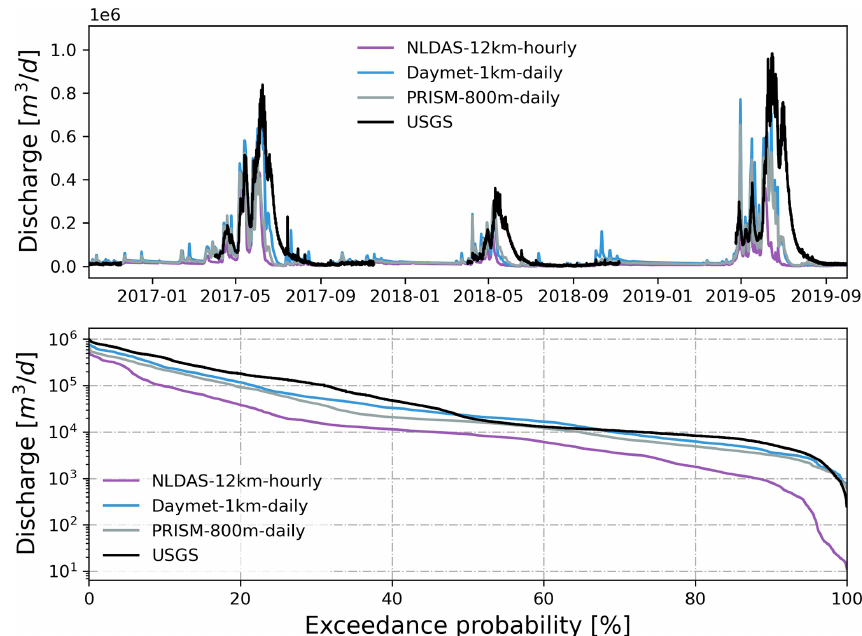
Figure 5. Simulated hourly discharge at the watershed outlet compared to USGS hourly streamflow forced by different precipitation from each GMF. Also shown is the flow duration curve comparison.